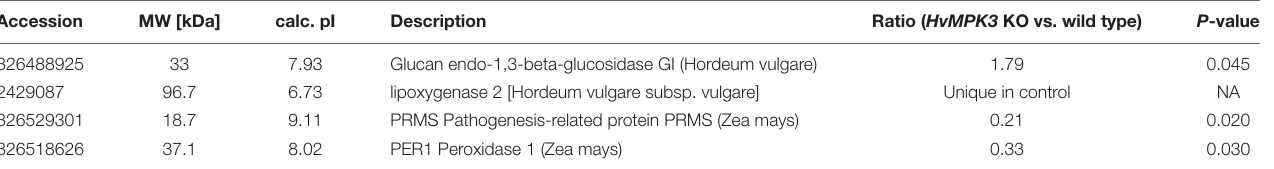
TABLE 3 | Differentially abundant defense related proteins found in flg22-treated barley HvMPK3 KO